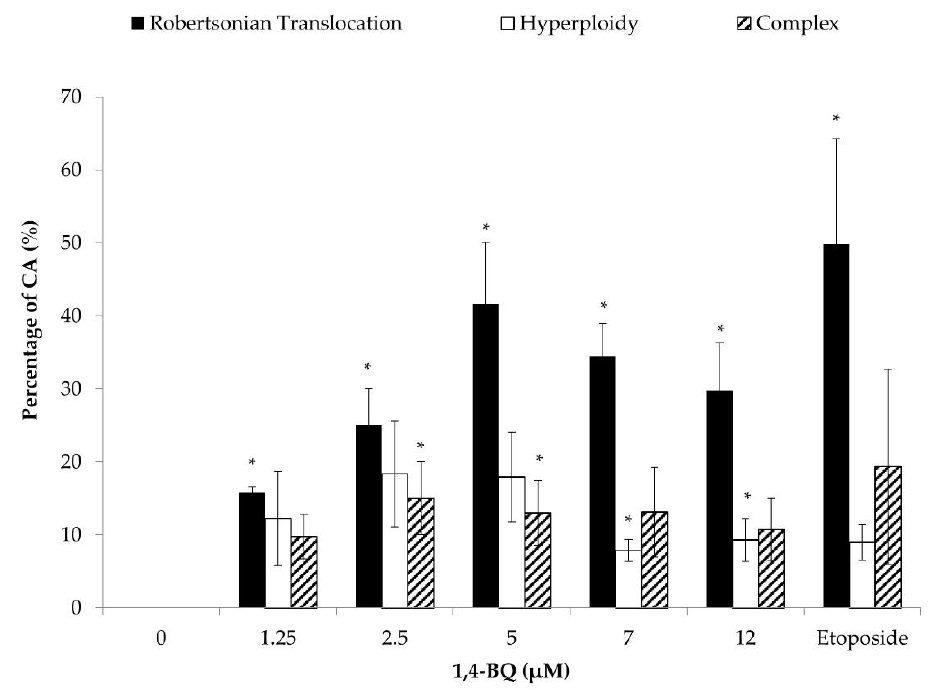
Figure 4. Effect of 1,4-BQ on different types of CA (Rb, hyperploidy, and complex) in MBMCs after 24 h of treatment with 1,4-BQ. Twenty metaphases were scored for each experimental group, and the percentage of each type of CA is as presented. Data are presented as the mean ± S.E.M. ( n = 3) and analyzed by using one-way ANOVA. * p < 0.05 compared with the negative control group.